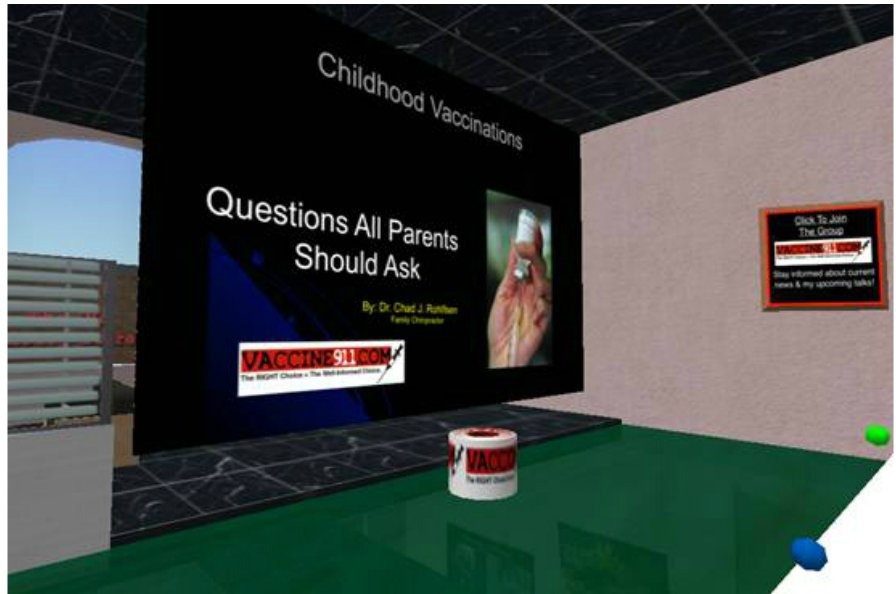
Figure 1. Screen capture from the Second Life Site of the Vaccine 911 auditorium: The Iowa Wellness and Spinal Tuning Center (SLurl 163,122,28; Image taken Dec 15,